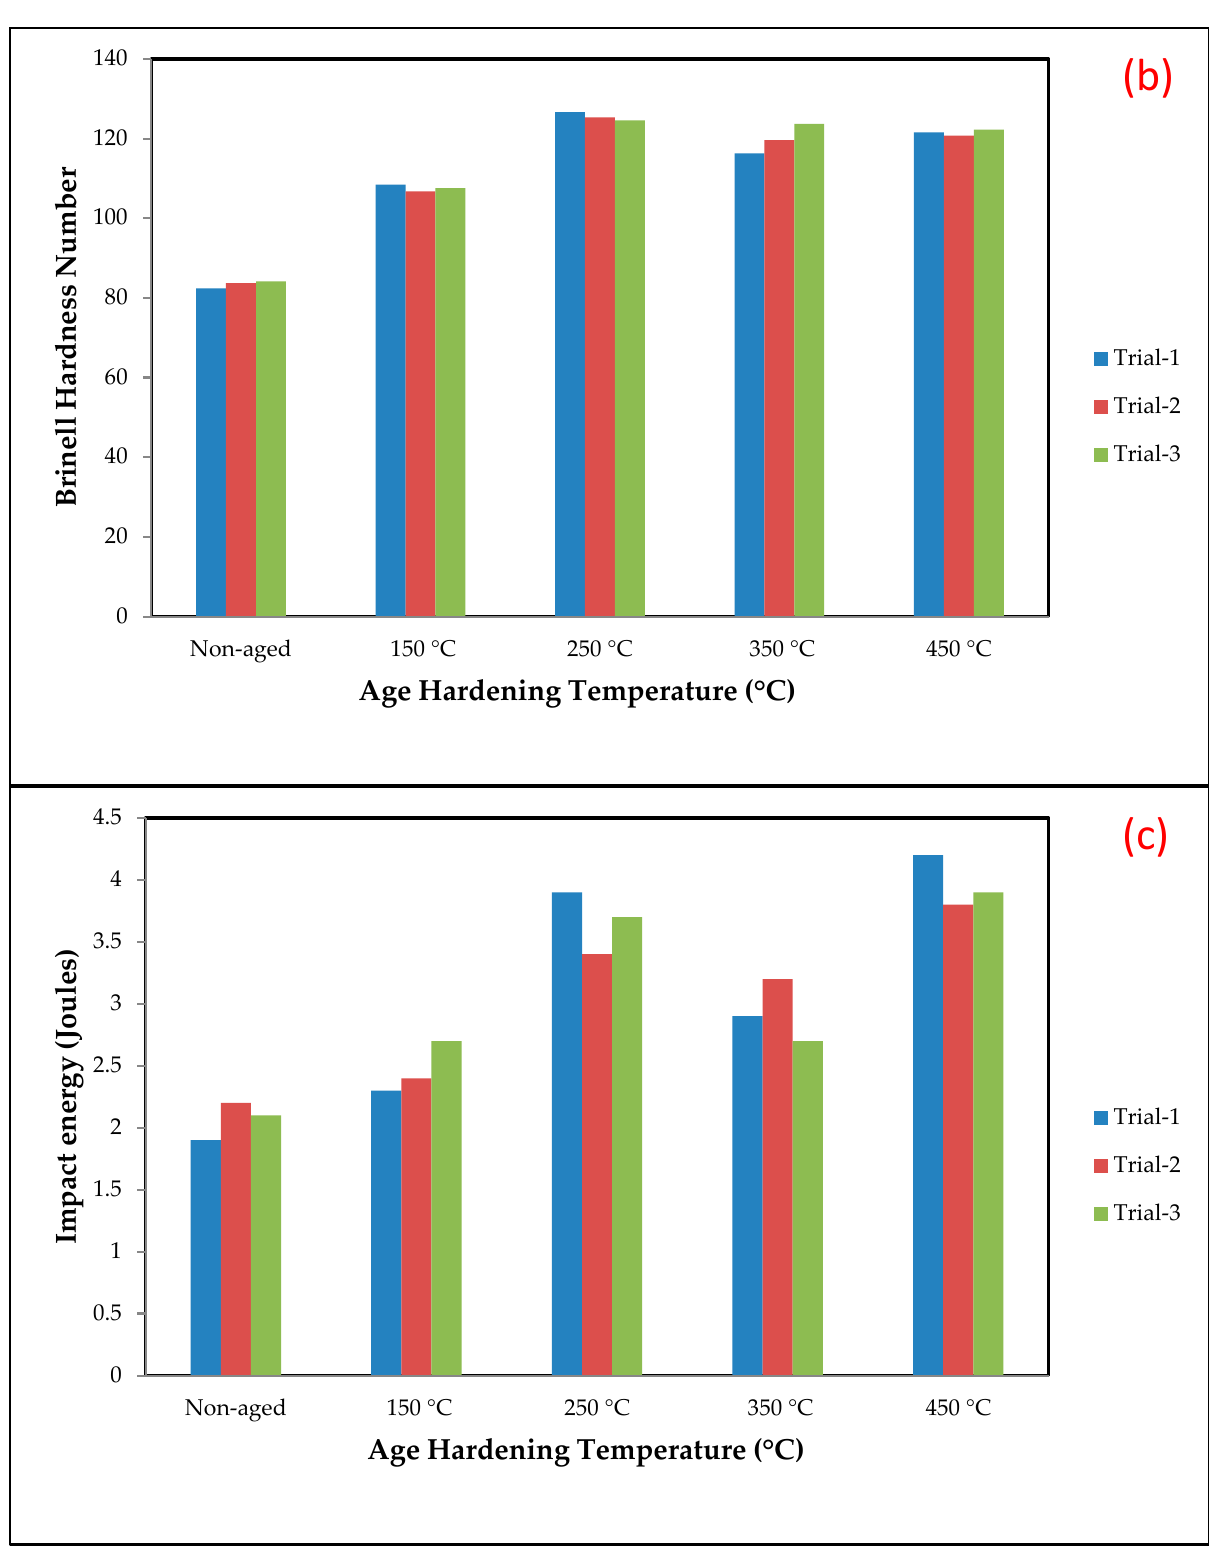
Figure 6. ( a ) Tensile strength, ( b ) Brinell hardness number, ( c ) impact energy of non-aged and aged at 150, 250, 350 and 450 °C composite specimens.